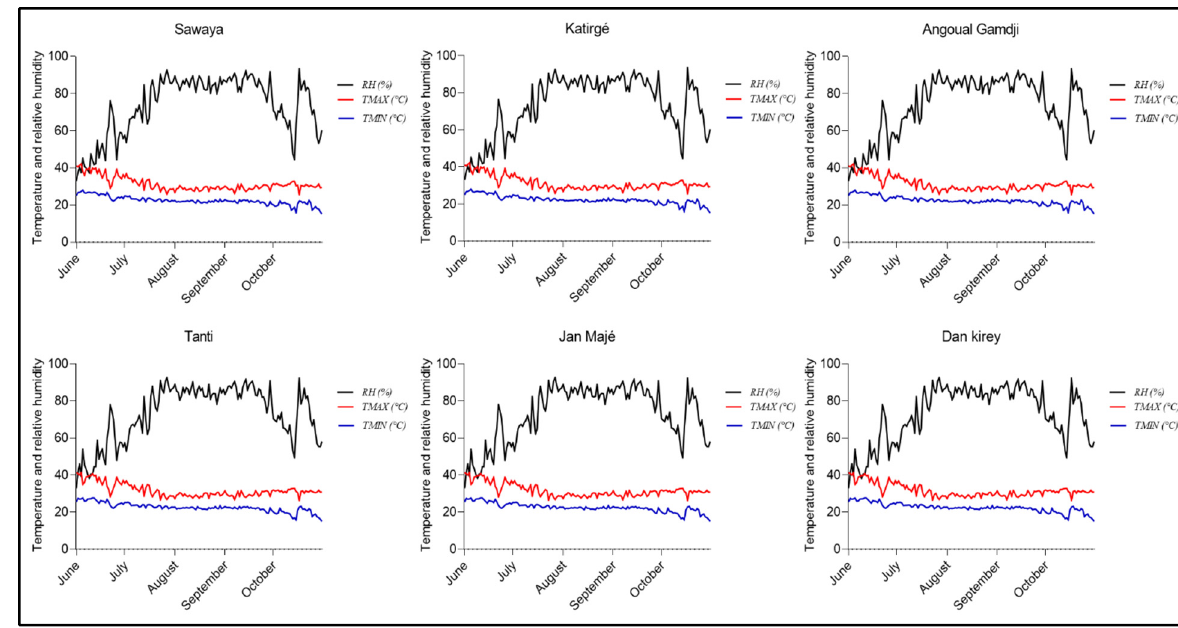
Figure 5. Temperature and relative humidity during the growing season at the study sites.